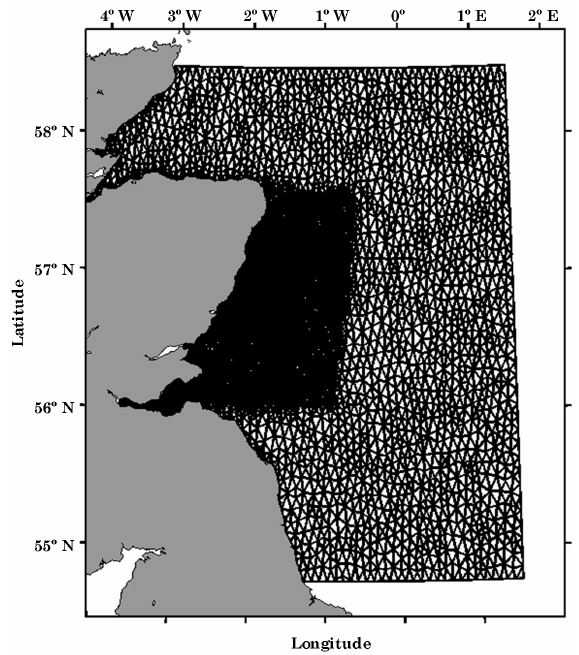
Figure 2. The computational grid generated with MIKE Zero soft-